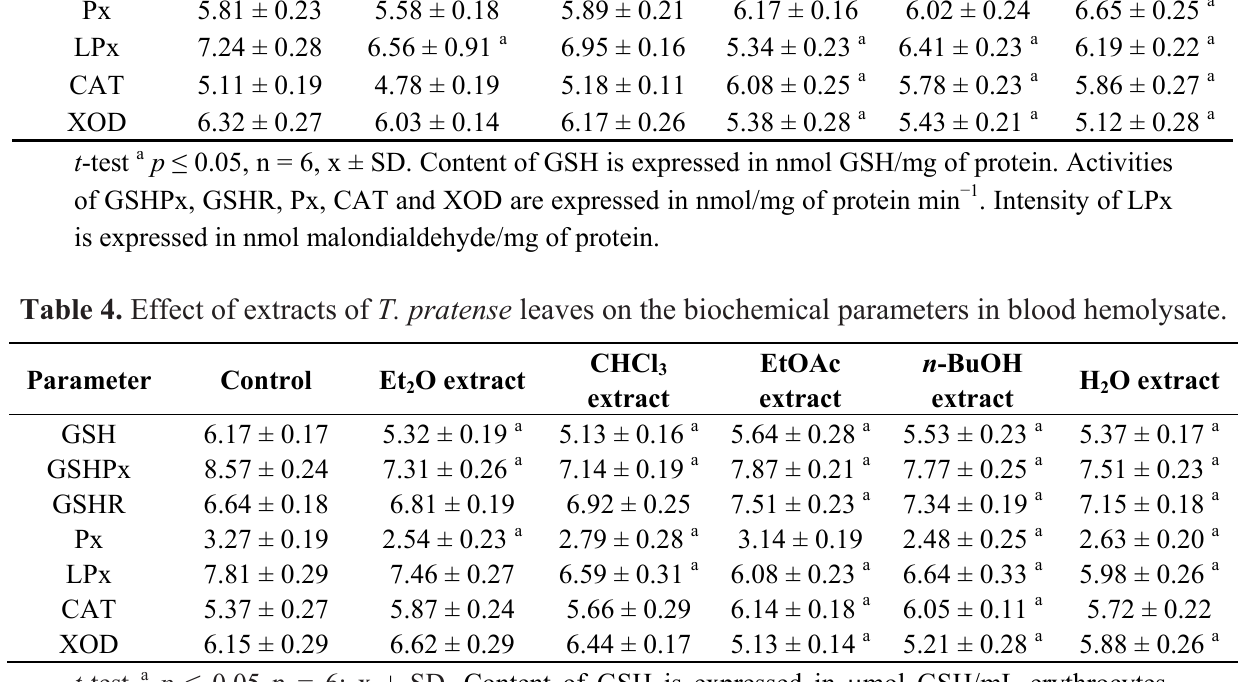
on the liver homogenate biochemical parameters. 4